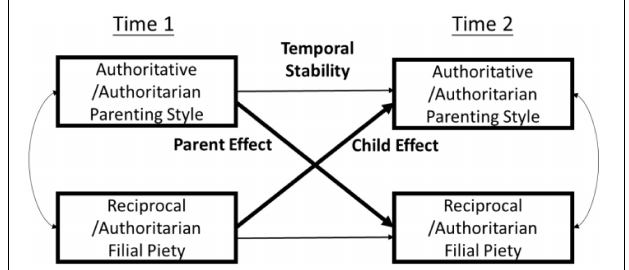
FIGURE 1 | An illustration of the path analysis. Covariates (i.e., gender and parental education) and residuals are omitted for clarity of presentation.